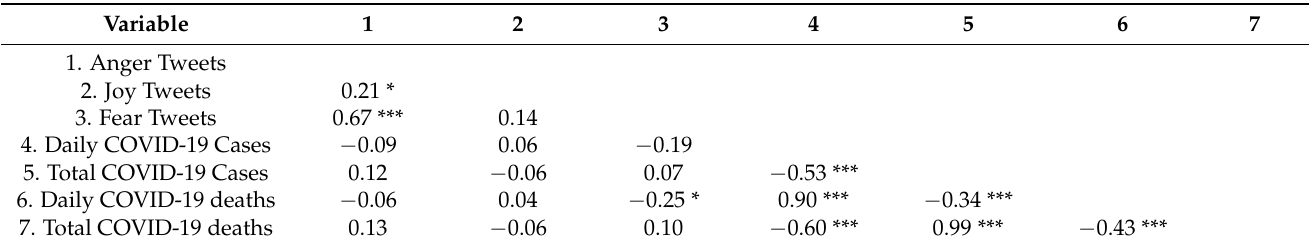
Table A4. Bologna Pearson’s correlation coefficient